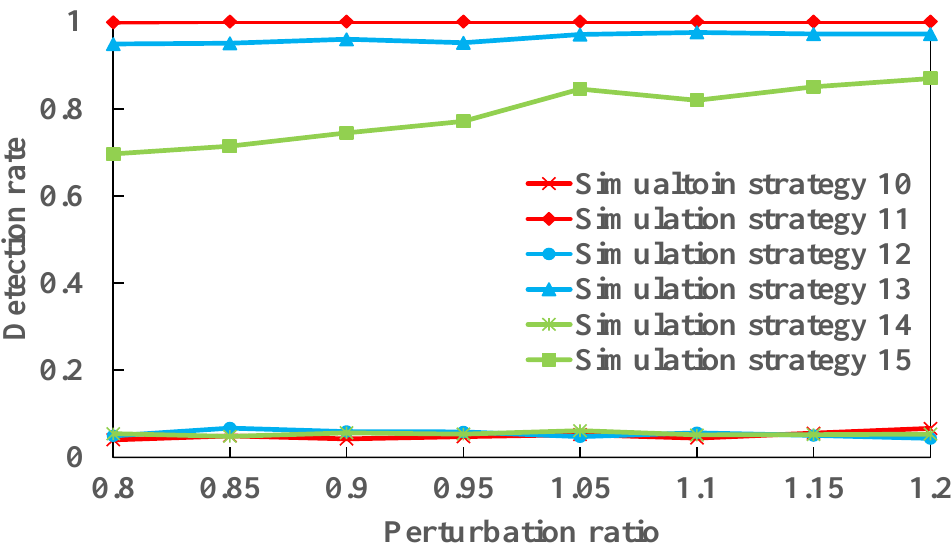
Figure 11. The detection rates in simulation strategies increase from 10 to 15 when the perturbation ratio increases from 0.8 to 1.2.